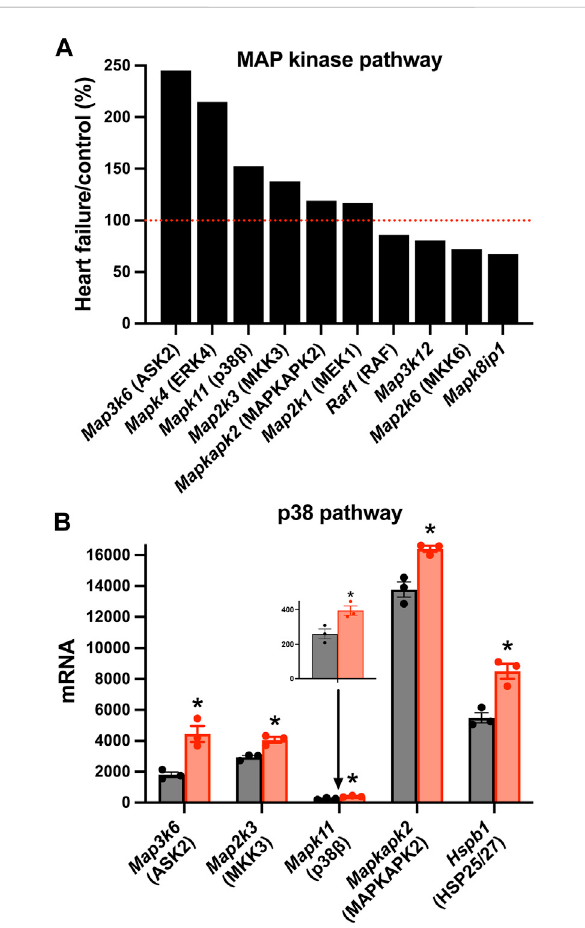
FIGURE 5 Changes in MAP kinase pathway transcripts in the AV node in HF. (A) , signi fi cant changes in the expression of MAP kinase pathway transcripts. Expression in HF mice is shown as a percentage of that in control mice. Red dotted line corresponds to 100%. (B) , mean (+SEM) expression (as well as individual data points) of p38 pathway transcripts in control (black bars) and HF (red bars) mice. The data for Mapk11 are also shown in a zoomed in panel. * p <